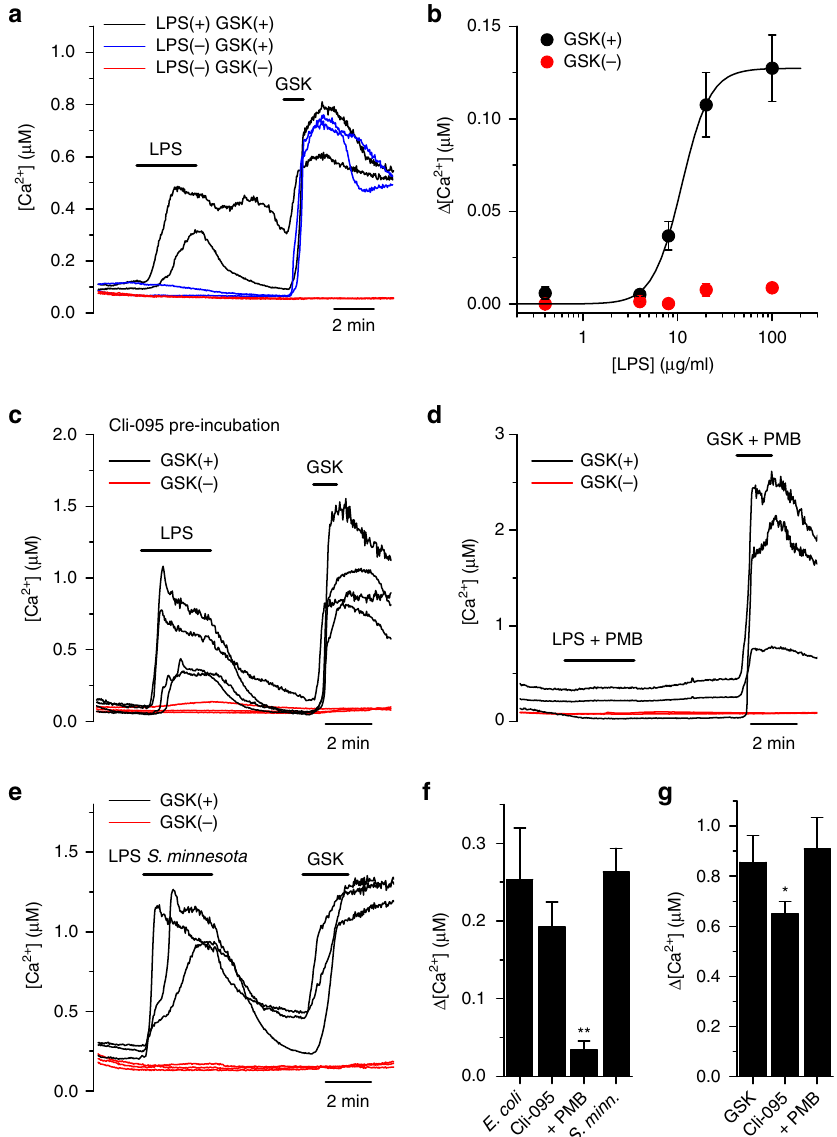
Fig. 3 LPS activates TRPV4 in a TLR4-independent manner. a Intracellular Ca 2+ signals in HEK293T cells overexpressing mouse TRPV4. The black and blue traces correspond to GSK1016790A-sensitive cells responding or not to 20 μ g ml − 1 of LPS, respectively. The red traces correspond to non-transfected cells (GSK1016790A-insensitive). b Concentration dependence of the amplitude of LPS-induced intracellular Ca 2+ responses ( n > 100 per data point). The solid line represents the fi t of the data obtained in GSK1016790A-positive cells with a Hill equation. The red symbols correspond to GSK1016790A-insensitive cells. c Intracellular Ca 2+ signals recorded in HEK293T cells pre-incubated with the TLR4 antagonist Cli-095 (1 μ M). d Intracellular Ca 2+ signals recorded in HEK293T cells treated with LPS pre-incubated with Polymixin B (PMB, 300 μ g ml − 1 ). In c , d , the black and red traces represent TRPV4-transfected and non-transfected cells, respectively. LPS 20 µ g ml − 1 and GSK1016790A (GSK) 10 nM. e Intracellular Ca 2+ signals in response to Salmonella minnesota LPS (20 μ g ml − 1 ). f Average amplitude of the intracellular Ca 2+ responses to 20 μ g ml − 1 LPS from E. coli and S. minnesota , and to E. coli LPS in the presence of